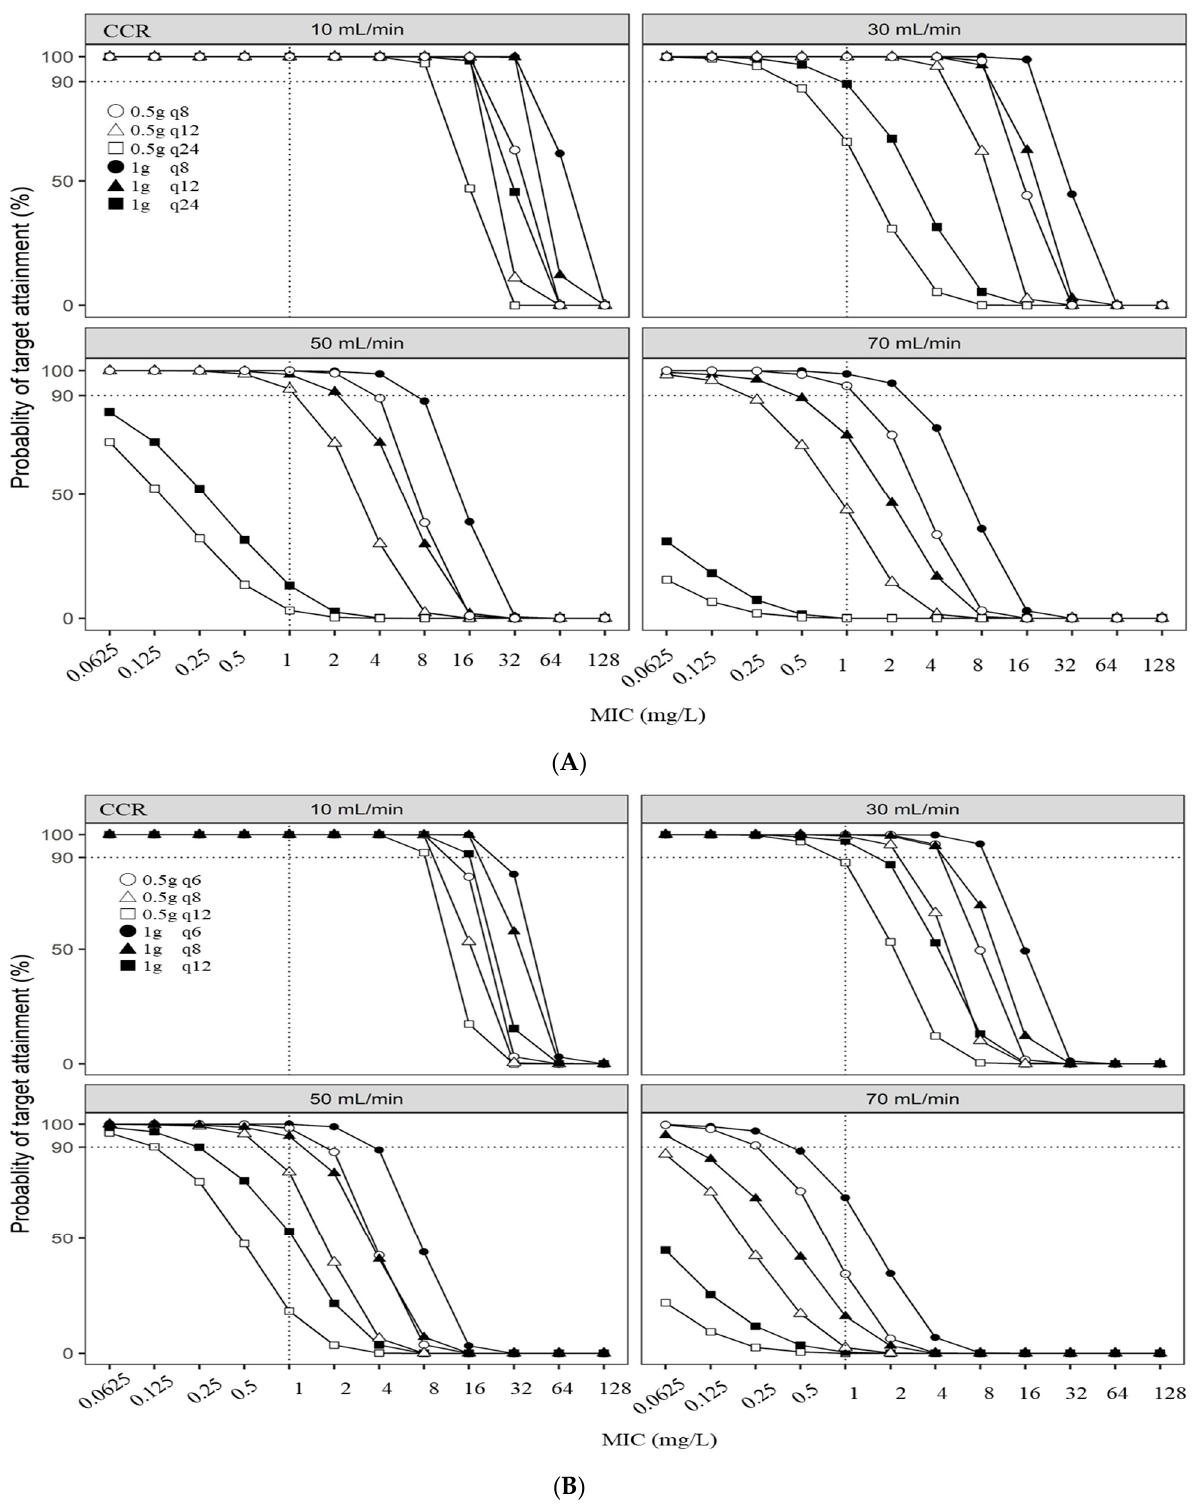
Figure 1. Probabilities of target attainment for cefmetazole ( A ) and flomoxef ( B ) doses with an infusion duration of 1 h were simulated. The model simulated cefmetazole and flomoxef clearance as a function of creatinine clearance (CCR) within four categories of estimated renal function: 10, 30, 50, and 70mL/min. The PTA was benchmarked on 70% cefmetazole and flomoxef concentration time above the MIC (70% T >